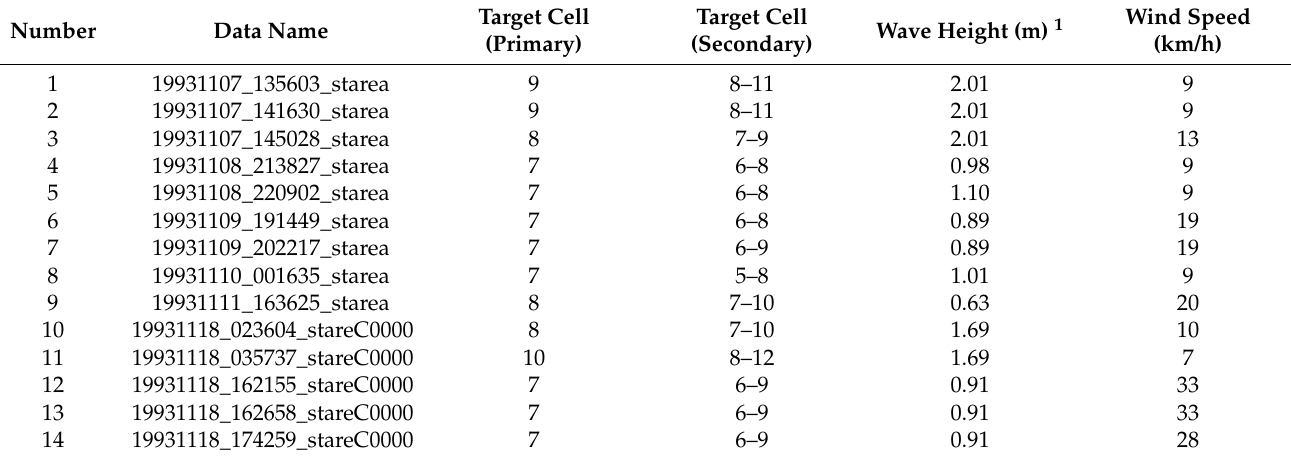
Table 2. Description of IPIX radar data acquired in